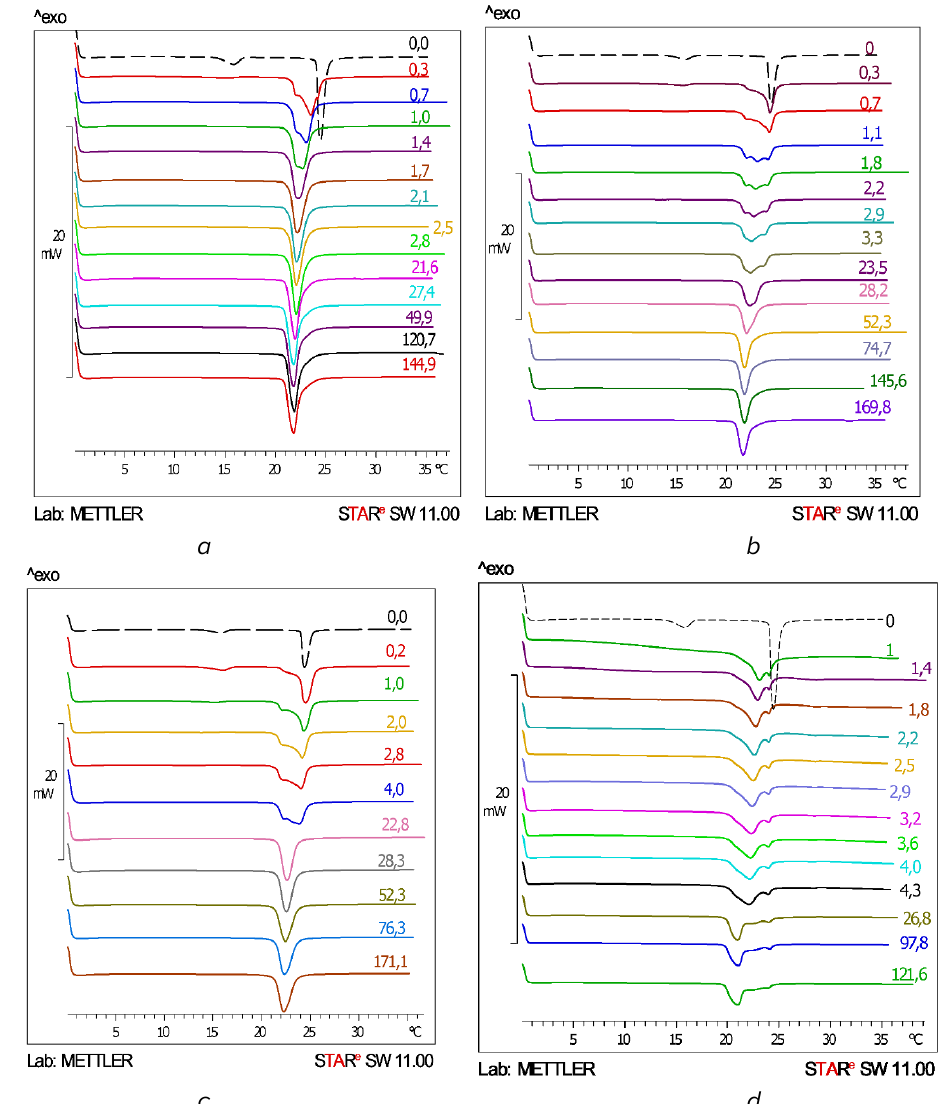
Fig. 3. DSC profiles of lipid membranes containing: a – paracetamol; b – Actimask; c – Actimask + glucosamine; d – tablet-mass. The numbers on the right of the curves indicate the time (in hrs) since the start of the experiment. The DSC profile of the neat lipid membrane (dotted line) corresponds to the time reference point (t=0)